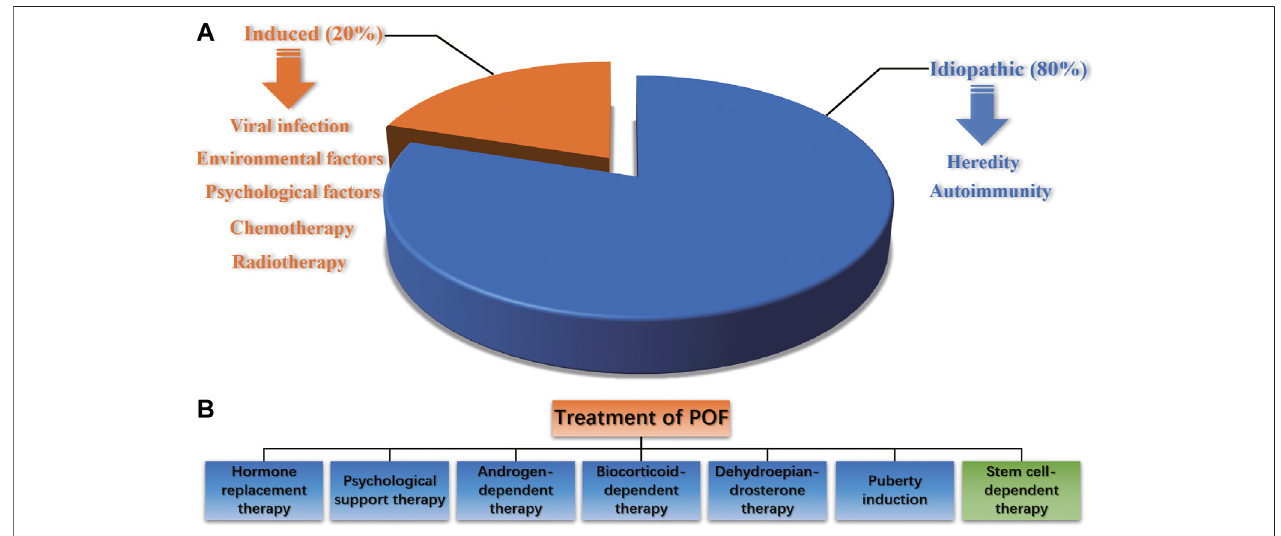
FIGURE 1 | The pathogenic factors and treatment options of